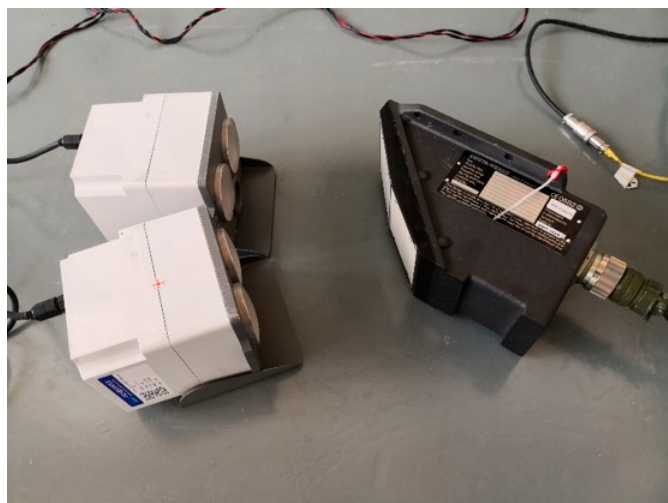
Figure 11. Calibration setup for the DRS05 / 1a sample.